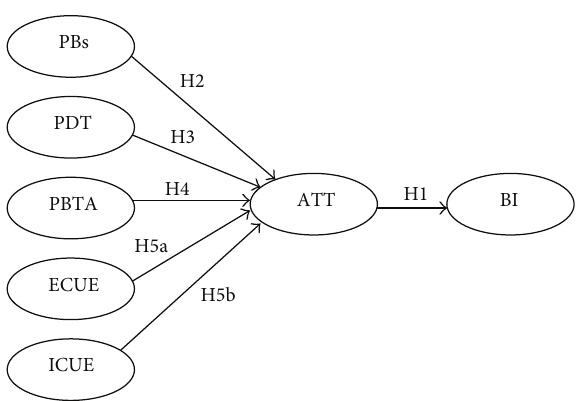
Figure 1: Research structure. Note: perceived benefits (PBs), per- ceived disease threat (PDT), perceived barriers of taking action (PBTA), external cues to action (ECUE), internal cues to action (ICUE), attitude toward using (ATT), and behavioral intention to use